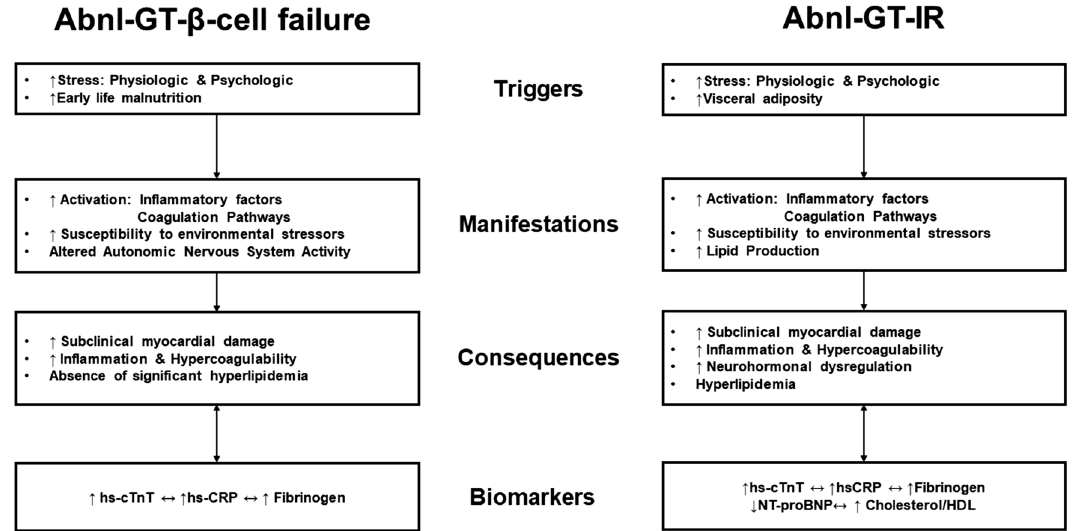
Figure 2. Comparison of pathways, triggers, and consequences which could link CVD risk biomarker profile to etiology of abnormal glucose